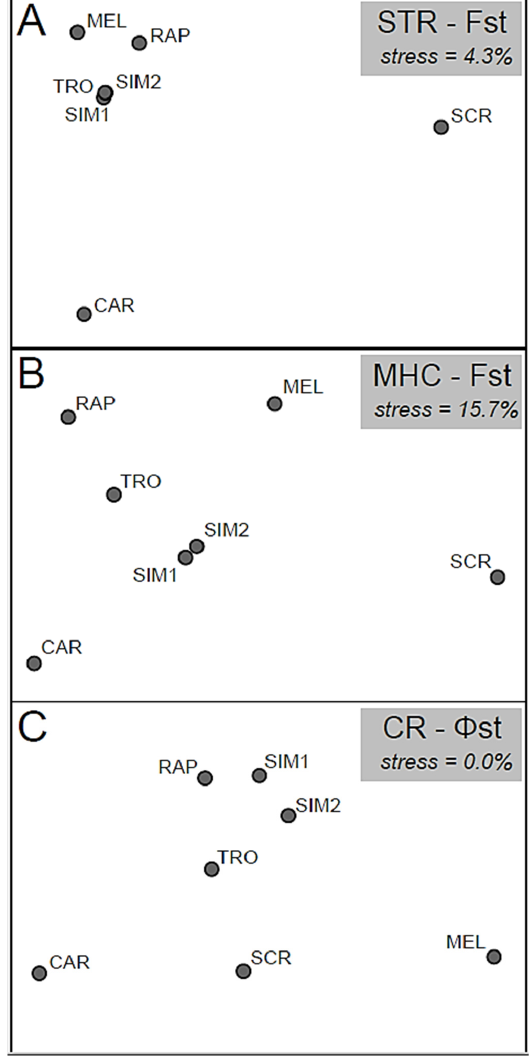
Figure 3. Non-metric two-dimensional scaling of the pairwise genetic distance (Fst or Φ st) matrix computed for: ( A ) 11 STR loci; ( B ) the MHC- DAB gene; and ( C ) the mitochondrial Control Region. Population abbreviations as in Table